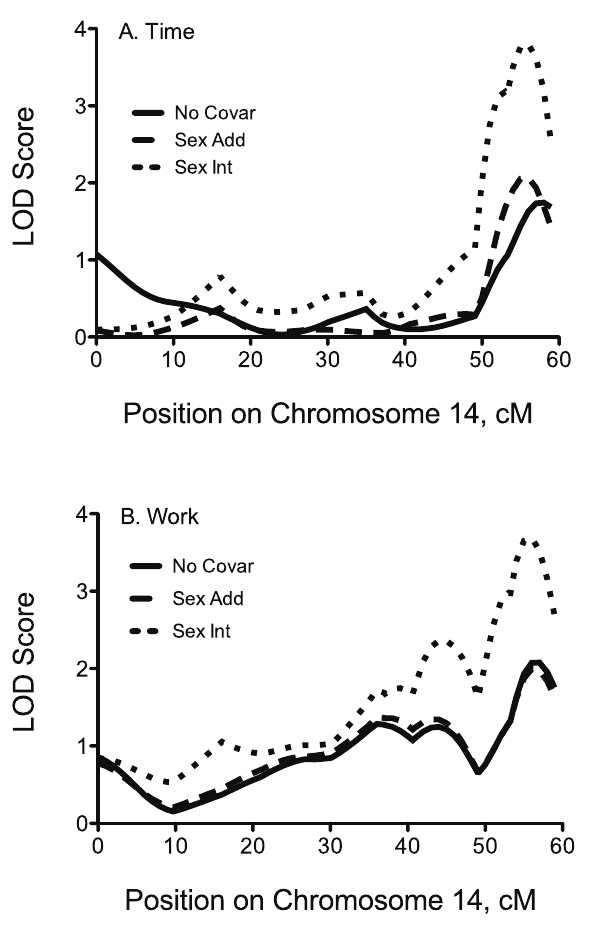
Figure 3. QTL analyses on mouse Chromosome 14 for intrinsic capacity expressed as time (min, A ) and work (kg·m, B ) in 155 (B6.A14 × B6) F mice. Three analyses were performed for each 2 phenotype: 1) with no covariates, 2) with sex as an additive covariate, and 3) with sex as an interactive covariate. For time, significant (P = 0.05) logarithm of odds (LOD) thresholds are 2.22 with no